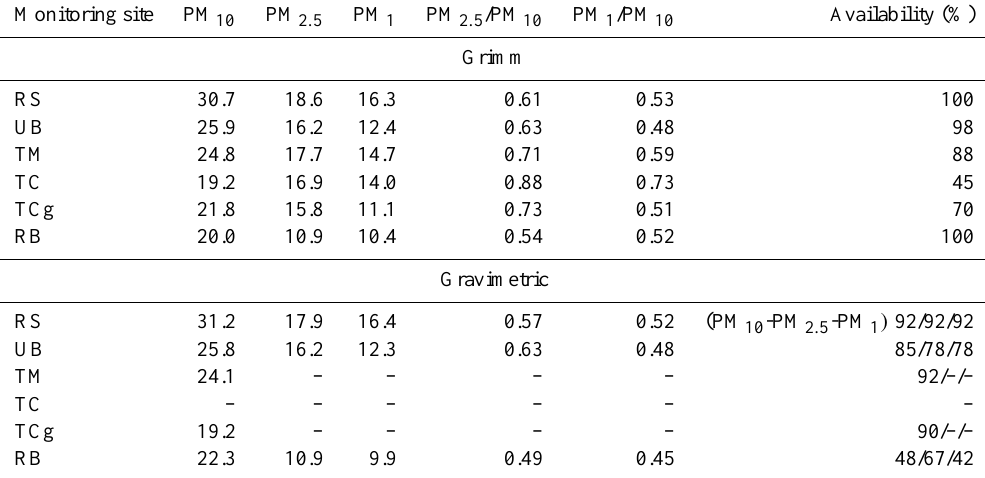
Table 5. Average aerosol mass loadings during